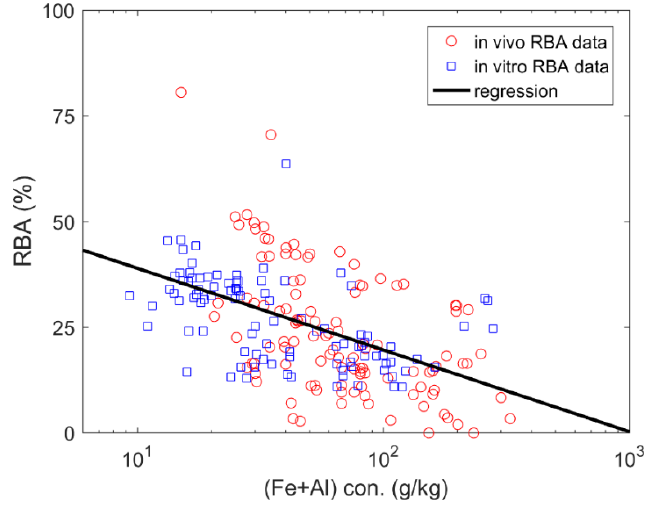
Figure 3. The relation between total content of the iron (Fe) plus aluminium (Al) concentration (con.) and arsenic relative bioavailability (RBA).